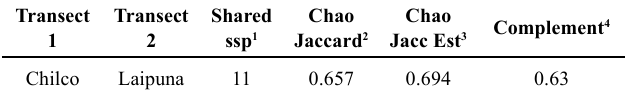
Table 3. Between site comparisons. 1 - number of species shared by 2 sites, 2 - Chao Jaccard similarity values, 3 - Chao Jaccard estima- tor values, 4 - dissimilarity or complementarity